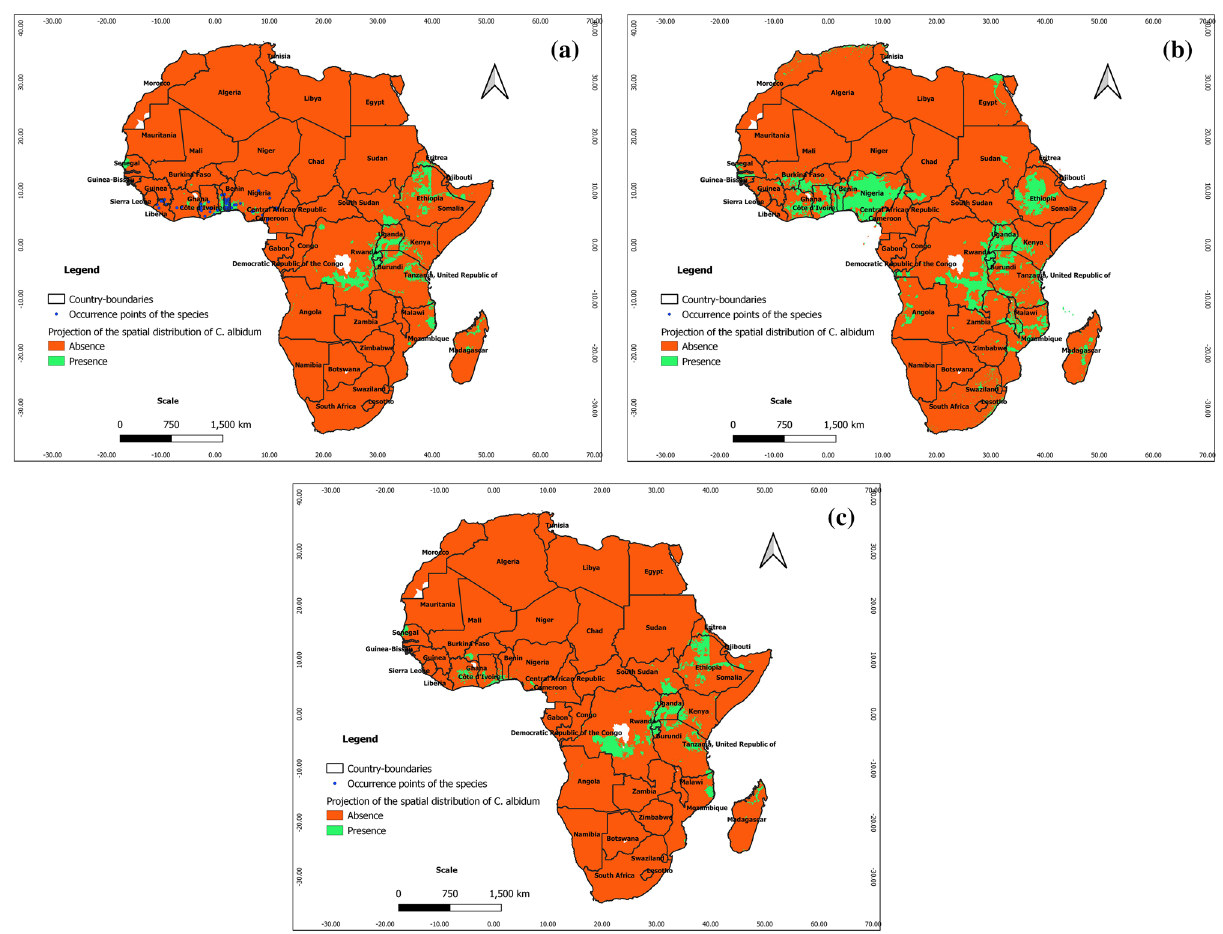
Figure 4. Projections of the spatial distribution of C . albidum according to Maxent across Africa: a) at present with occurrence points; b) at horizon 2055 rcp 8.5; c) at horizon 2060 SSP585 (the maps were generated using